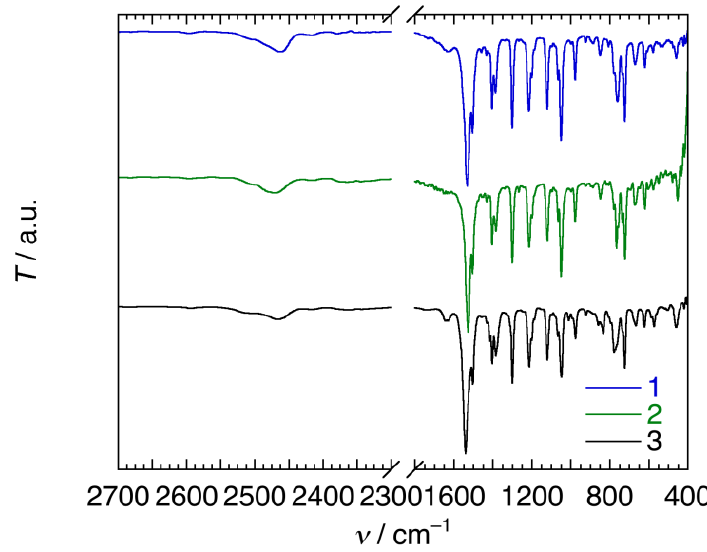
Figure 1. Infrared (IR) spectra for 1 – 3 at room temperature.